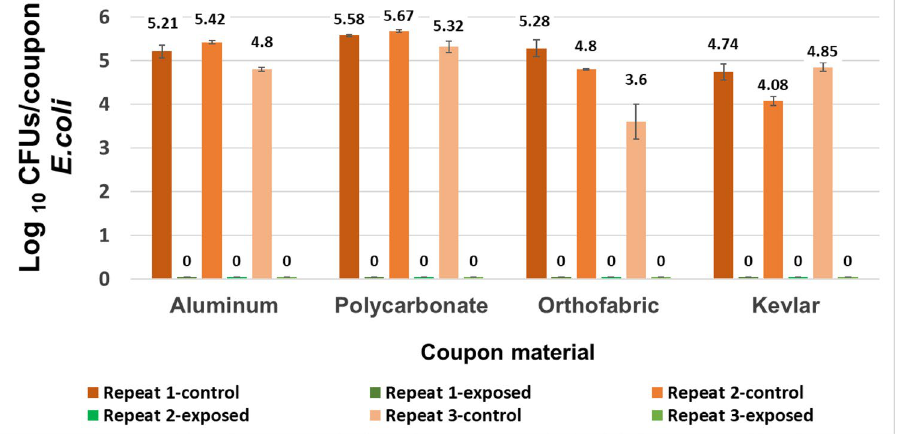
Figure 9. Data showing bacterial population of E. coli (CFUs/coupon) in exposed coupons (averaged over 11 coupons placed inside the APS) and control coupons (averaged over 3 coupons placed outside the APS) for four coupon materials, each repeated three times. Complete killing (4 to 5 log reduction) was achieved in each case using 4 CPPRs and exposures of 20 min (15 min CPPR on + 5 min CPPR off).